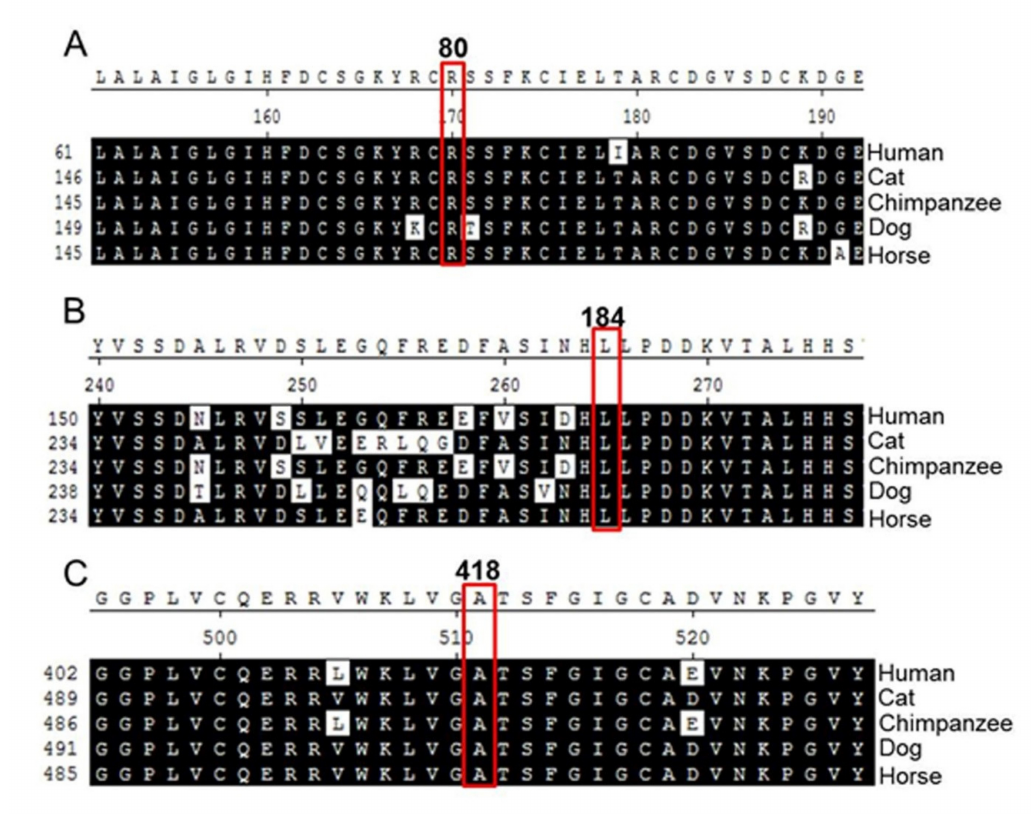
Figure 2. Alignment of the amino acid sequences of TMPRSS3 proteins of various species. The ( A ) p.Arg80, ( B ) p.Leu184, and ( C ) p.Ala418 residues, which were variants in this study, are indicated in bold. Arg (R) at codon 80, Leu (L) at codon 184, and Ala (A) at codon 418 are identical among all species